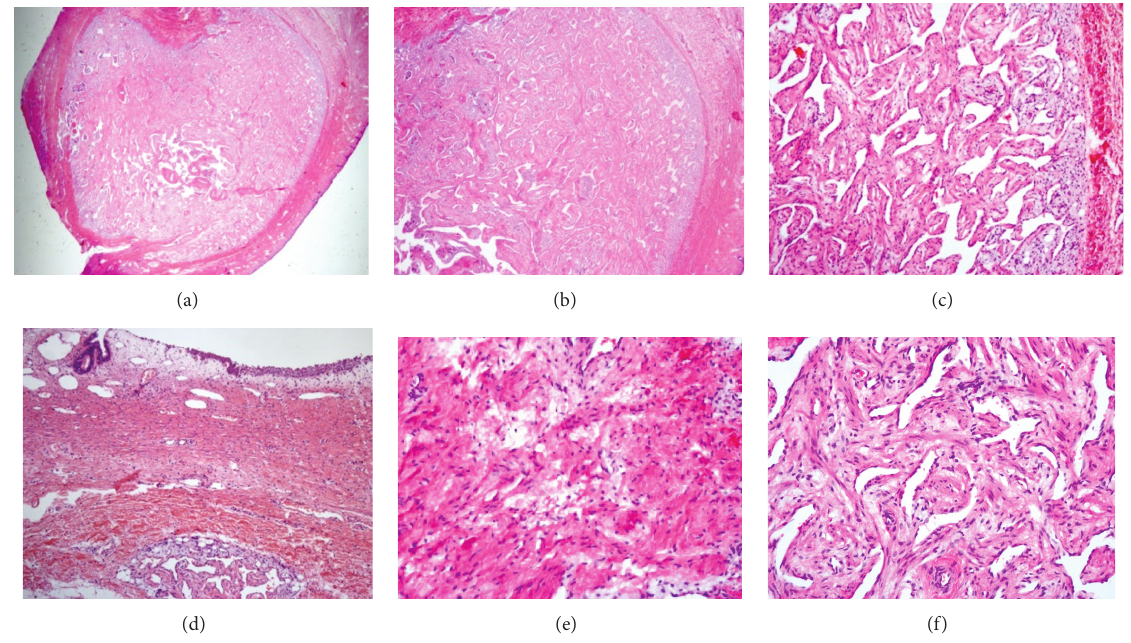
Figure 4: Pathology. (a–d) ( Haematoxylin/eosin ): nodular proliferation with superficial normal urothelium; (e) peripheral zones have myoid short fascicles/whorls/nodules of plump myofibroblasts with pale pink cytoplasm and long, tapering nuclei with vesicular chromatin and 1-2 small nucleoli, but no atypia or pleomorphism, often associated with hyalinization, and whorls/nodules can have a vaguely chondroid or chondromyxoidappearance;(f)centralzonesbetweentheperipheralmyoidnodulesdisplaycellularareasofround,polygonal,orspindlecells with scant cytoplasm, hyperchromatic nuclei, arranged around thin walled branching ectatic “hemangiopericytic” vessels; often calcification, necrosis, and hyalinization; often apparent subendothelial intravascular growth but still benign with minimal mitotic